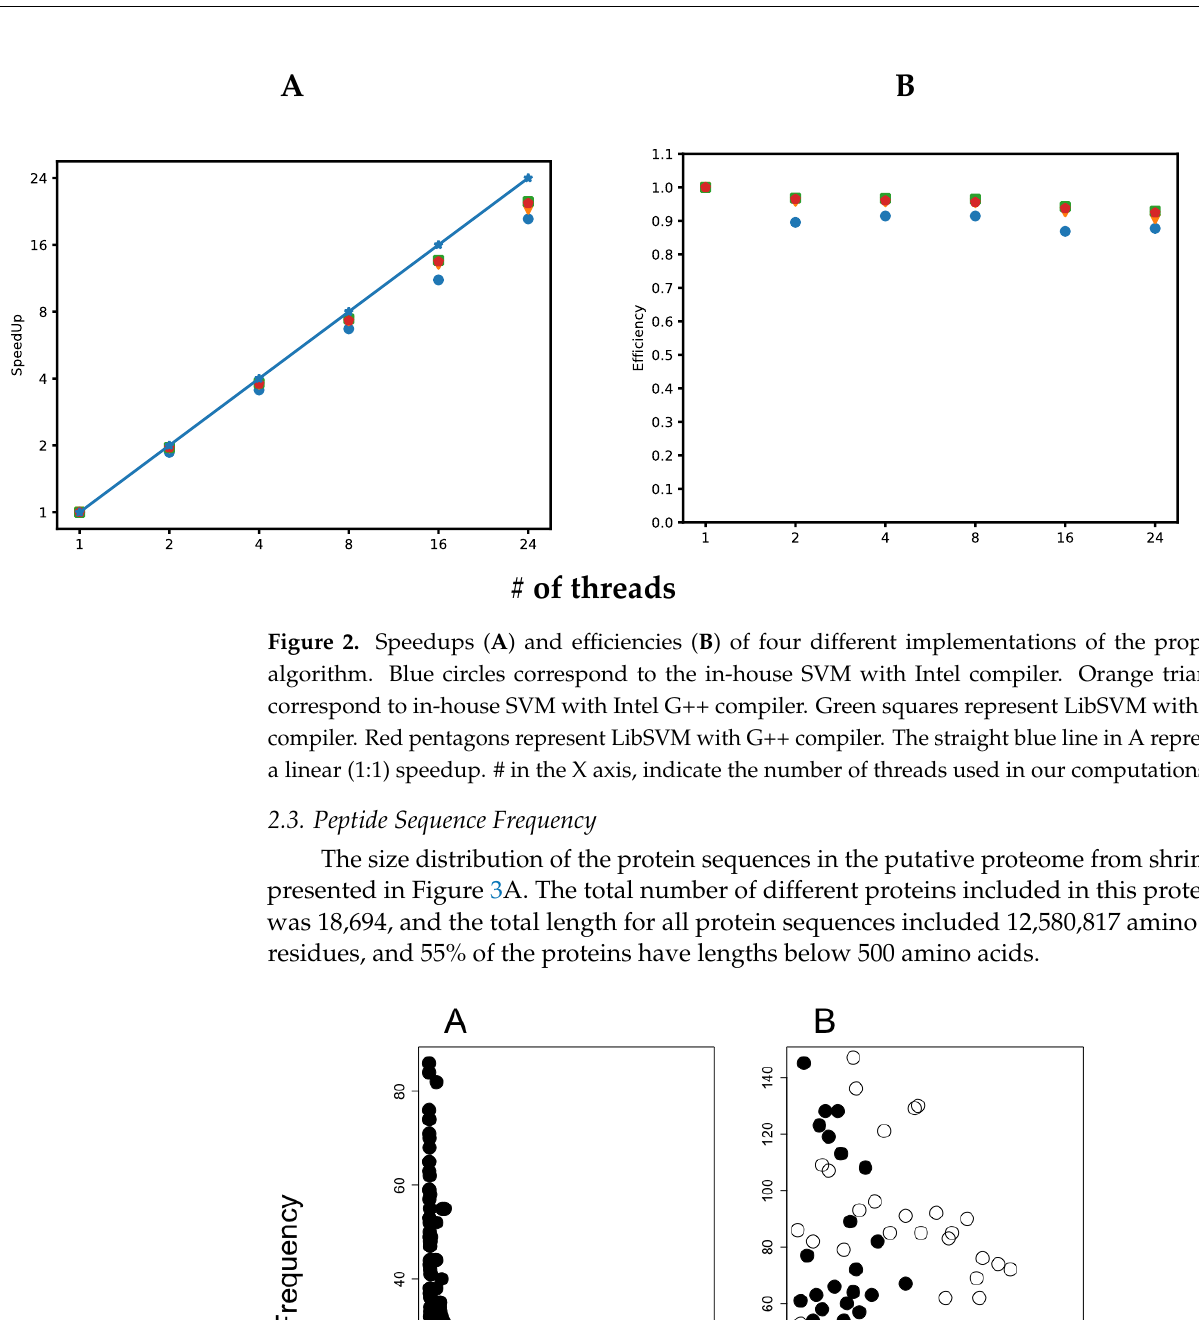
Figure 3. Length distribution of shrimp and AMP training set. ( A ) Protein length for the shrimp proteome and ( B ) the lengths for AMPs (black-filled circles) and non-AMPs (black empty circles) are presented with the observed frequency in the training set for our in-house SVM AMP classifier. 2.4. Testing Predictions of Embedded AMP on Shrimp Proteome The predictions of AMPs from the shrimp’s proteome are presented in Figure 4. We observe the larger the k -mer, the lower the probability to be predicted as AMPs or non-